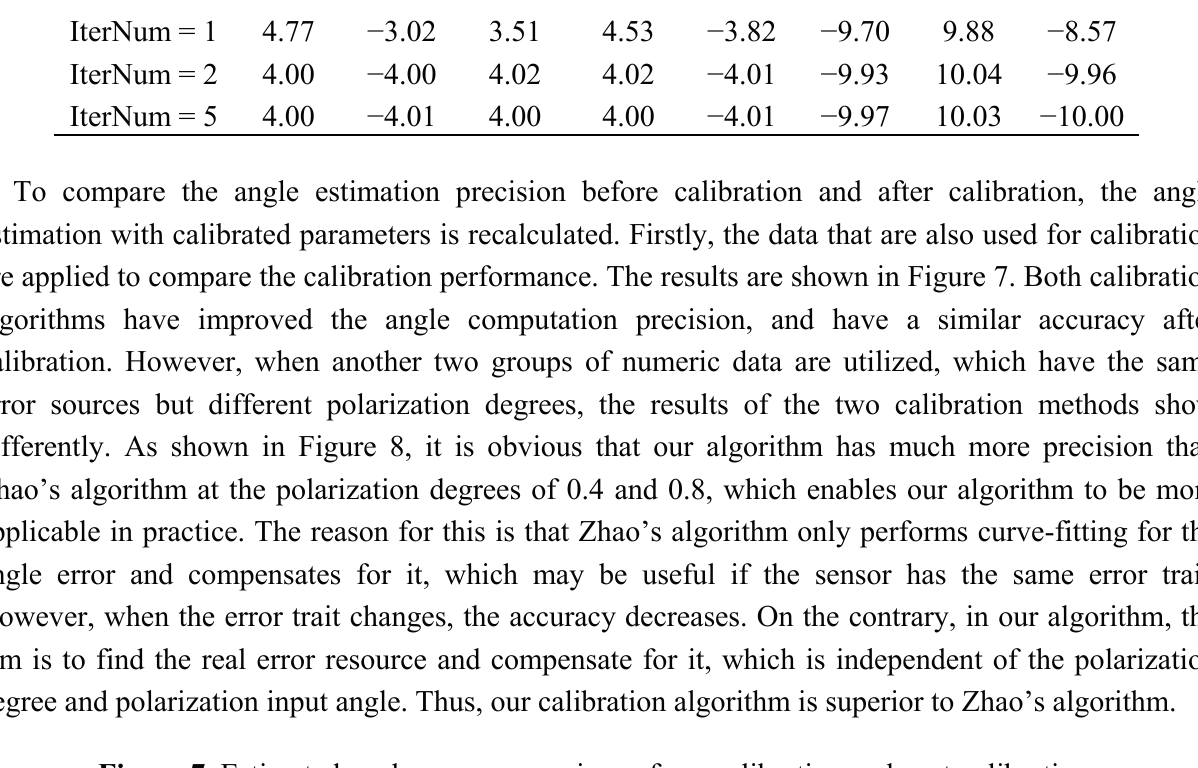
Figure 7. Estimated angle error comparison of pre-calibration and